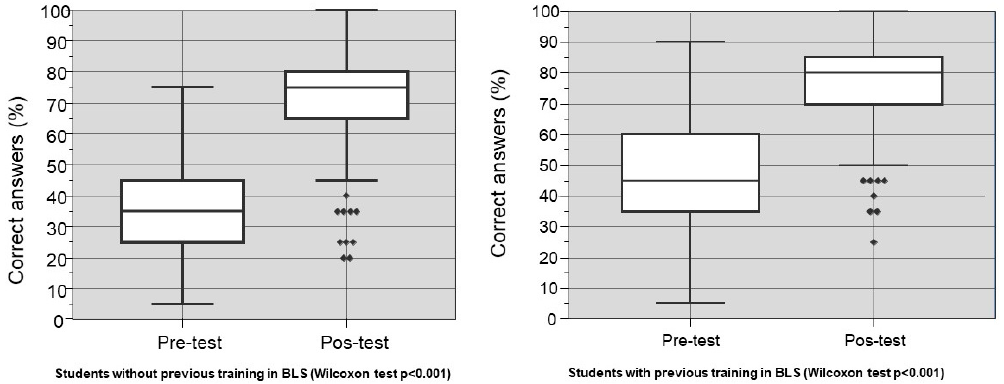
Figure 3. Distribution of correct answers (%) between students with and without previous training in basic life support (BLS) (Willcoxon test p < 0.001). Points: post-test outliers and squares: post-test outliers